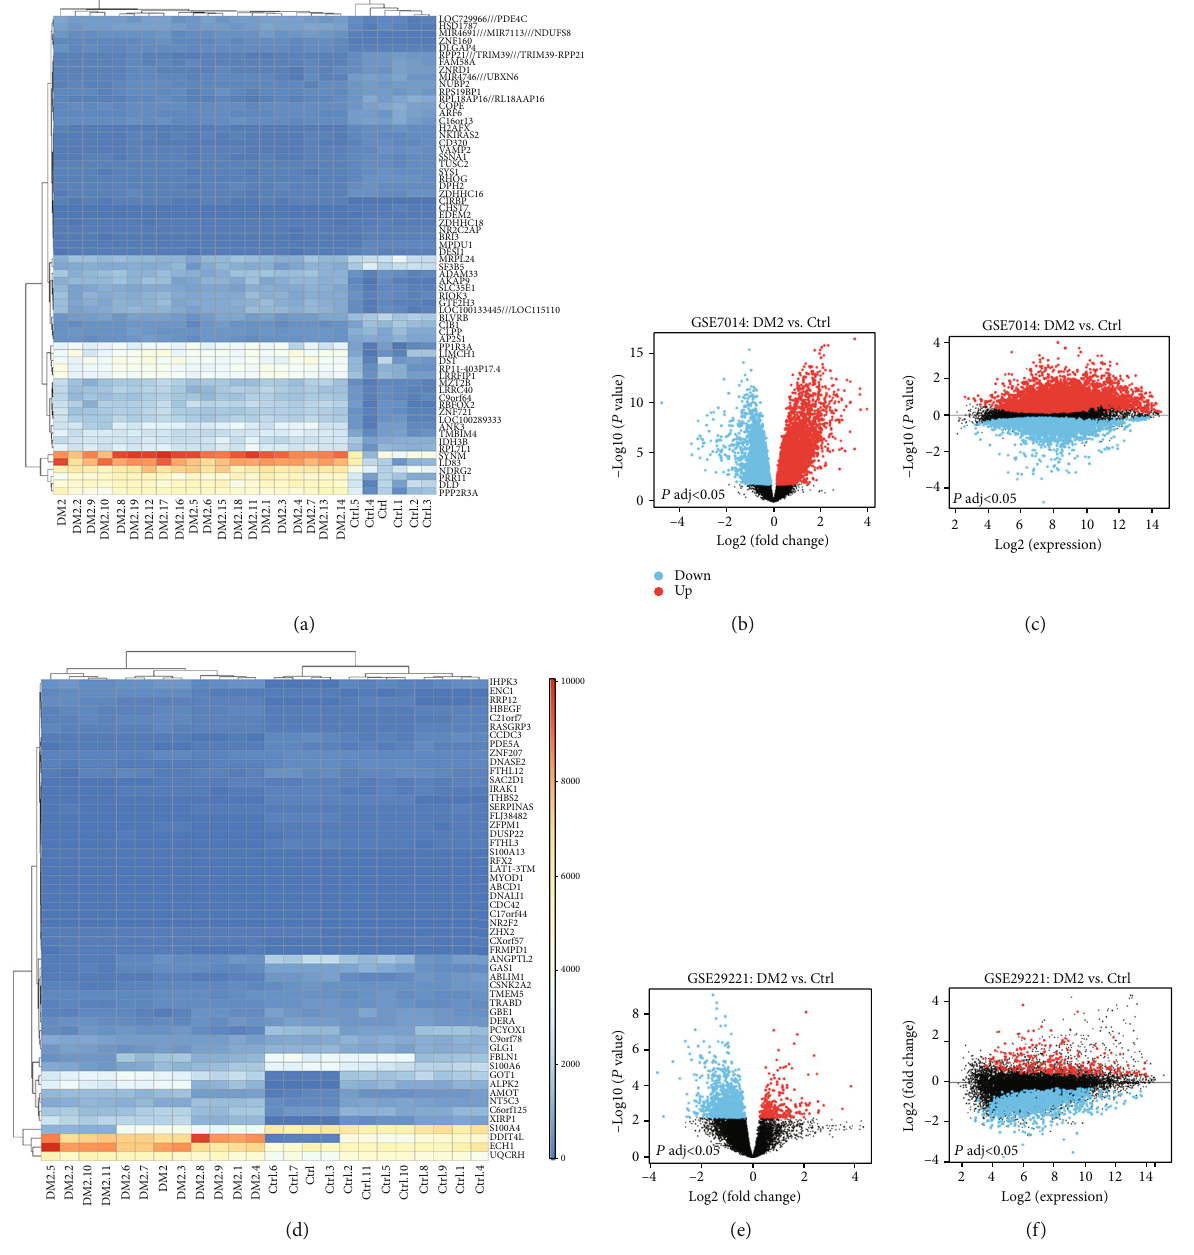
Figure 1: Detection of di ff erentially expressed genes (DEGs) in the GSE7014 and GSE29221 datasets. (a) An expression heat map of the top 80 DEGs in the GSE7014 dataset, as determined based upon P values. (b) A volcano plot corresponding to the GSE7014 dataset. (c) A Meandi ff plot for the GSE7014 dataset. (d) An expression heat map of the top 80 DEGs in the GSE29221 dataset, as determined based upon P values. (e) A volcano plot corresponding to the GSE29221 dataset. (f) A Meandi ff plot for the GSE29221